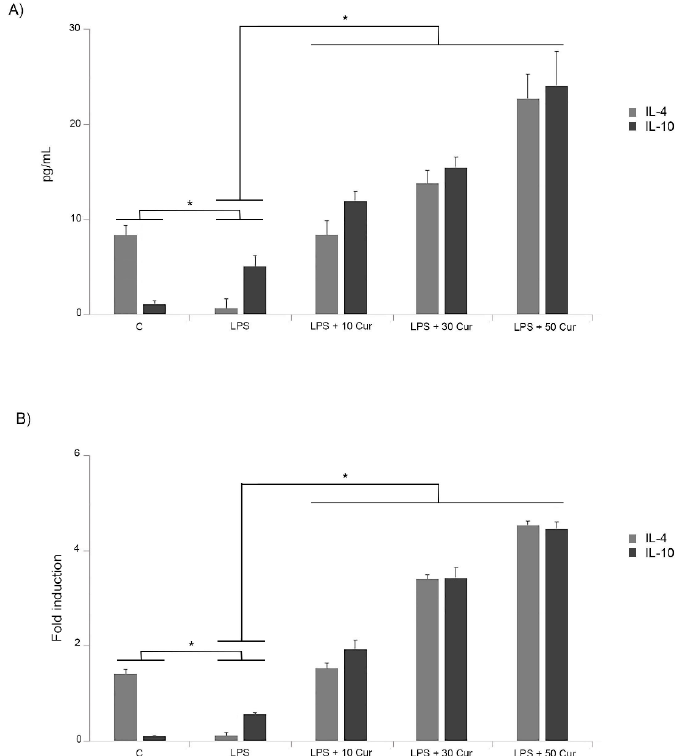
Figure 1. Effect of different concentrations (10, 30, 50 µ M) of curcumin (Cur) on anti-inflammatory cytokines production in lipopolysaccharide (LPS)-stimulated BV-2 cells. C = controls. ( A ) ELISA assay. Cells were treated with the indicated concentrations of curcumin for 1 h before LPS (1 µ g / mL) treatment. Supernatants were collected at 24 h after LPS treatment, and the amounts of IL-4 and IL-10 were measured. ( B ) Reverse transcriptase–polymerase chain reaction (RT-PCR). BV-2 microglial cells were incubated for 6 h with LPS alone or after 1 h of curcumin pretreatment. The experiments were performed in triplicate, and data are expressed as the mean ± SD of five independent experiments. * p <